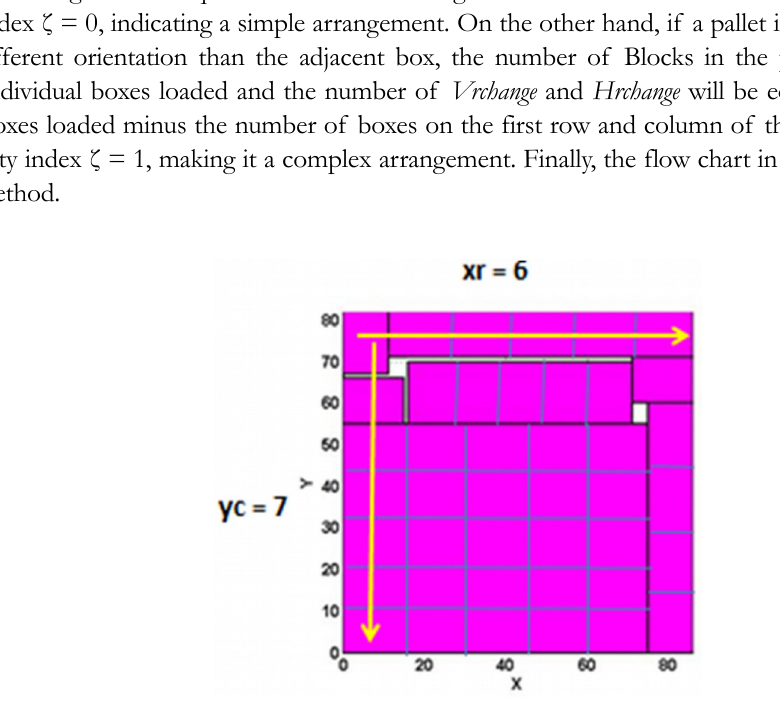
Figure 3. Calculation of xr and yc for Complexity Index